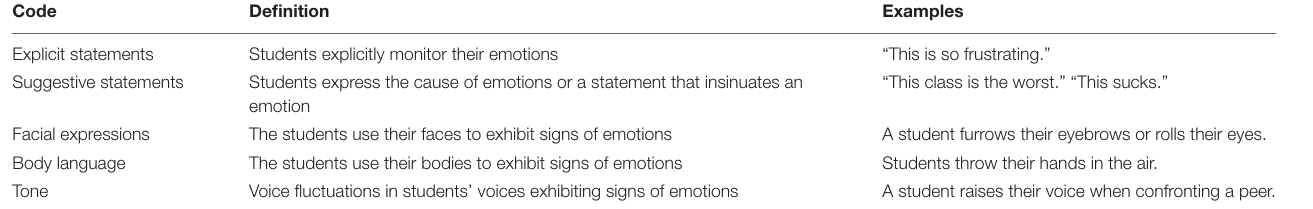
TABLE 2 | Levels of inference